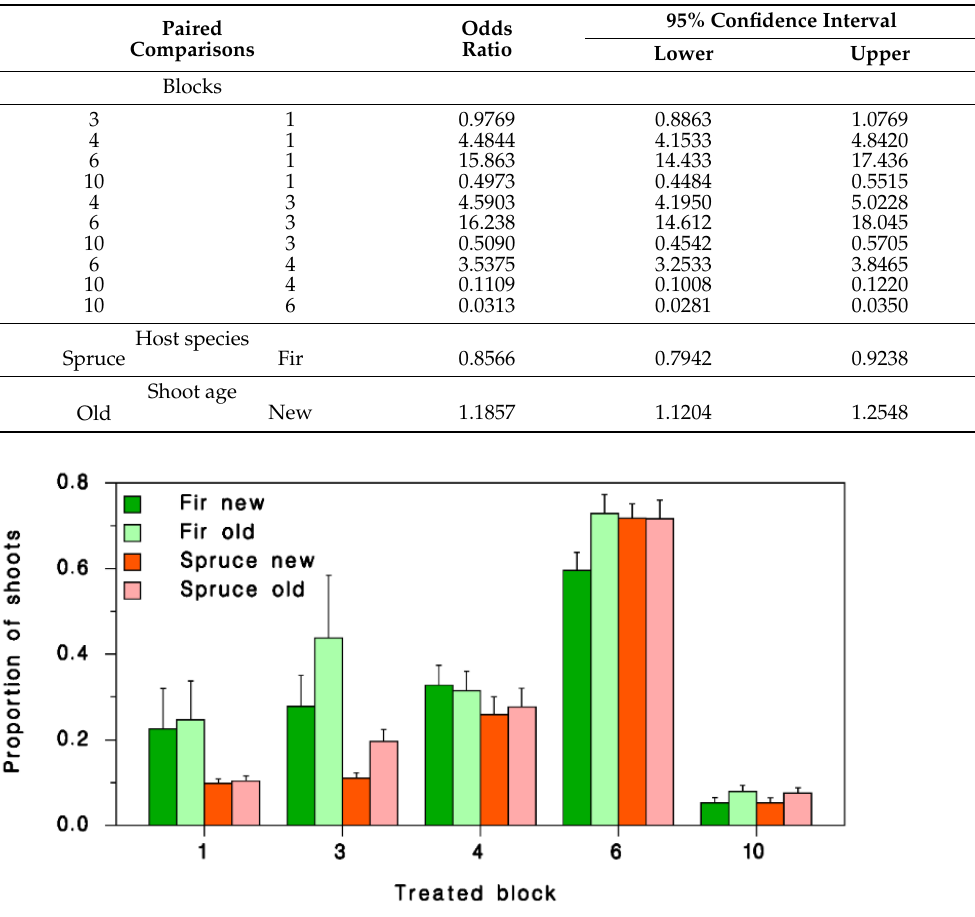
Figure 4. Mean ( ± SEM) proportion of shoots with at least one spray droplet on branches collected within blocks treated with CONFOUND SBW . Green: balsam fir; red: spruces; dark: current-year shoots; pale: older shoots.